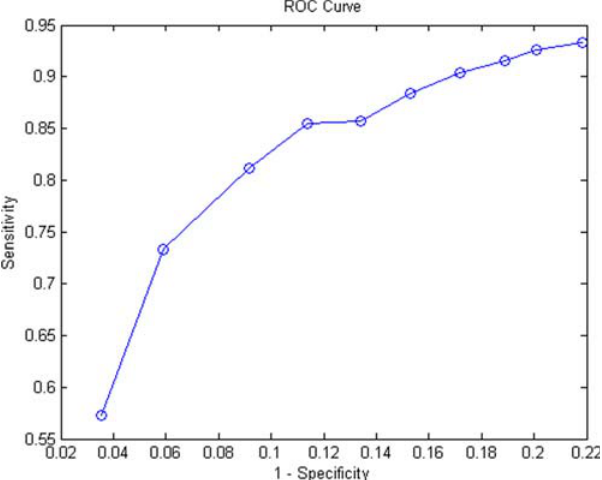
Figure 4. Domain distribution of organisms: S. cerevisiae, C. elegans,D.melanogaster , and H.sapiens. In our interaction data, the four organisms share 493 domains in common as shown in the figure. There are total 1603, 1489 and 1988 common domains between D. melanogaster and the other three organisms, S. cerevisiae , C. elegans , and Human,